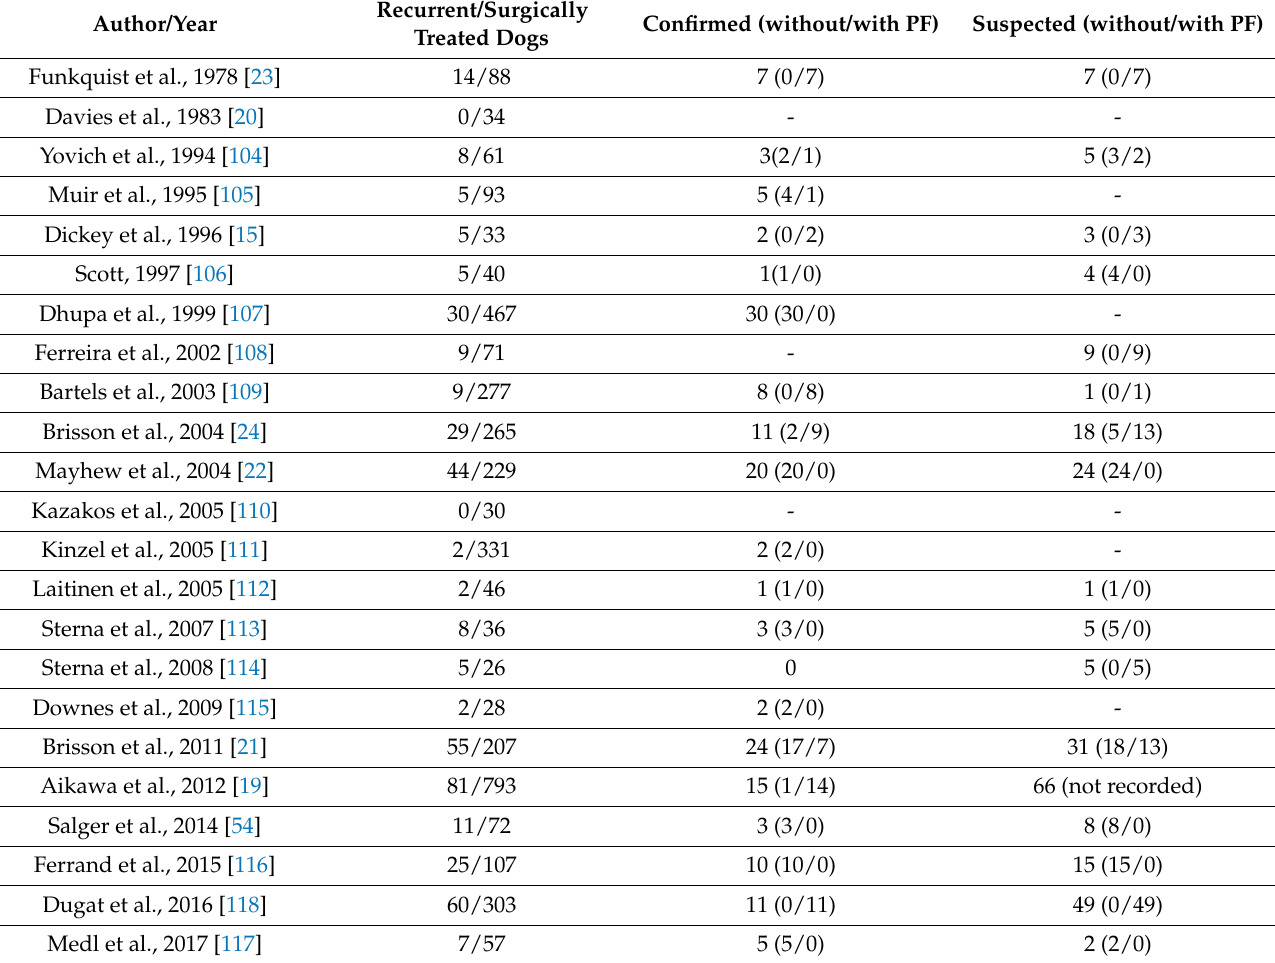
Table 3. Summary of the recurrent